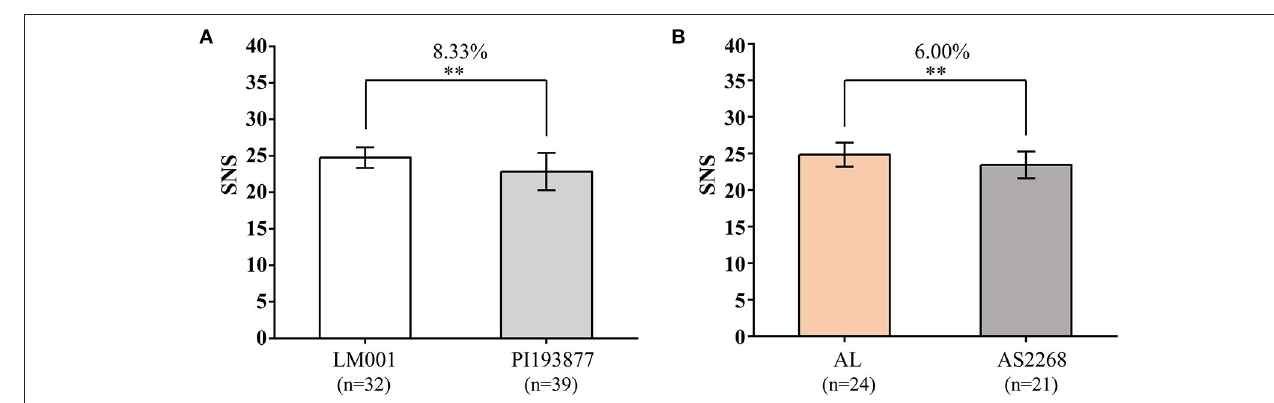
FIGURE 6 | Validation of (A) QSns.sau-AM-2B.2 (KASP-AX-111588559) and (B) QSns.sau-AM-3B.2 (KASP-AX-110548993) in LM001 × PI193877 and AL × AS2268 populations by Student’s t -test, respectively. **Significance level at p < 0.01.